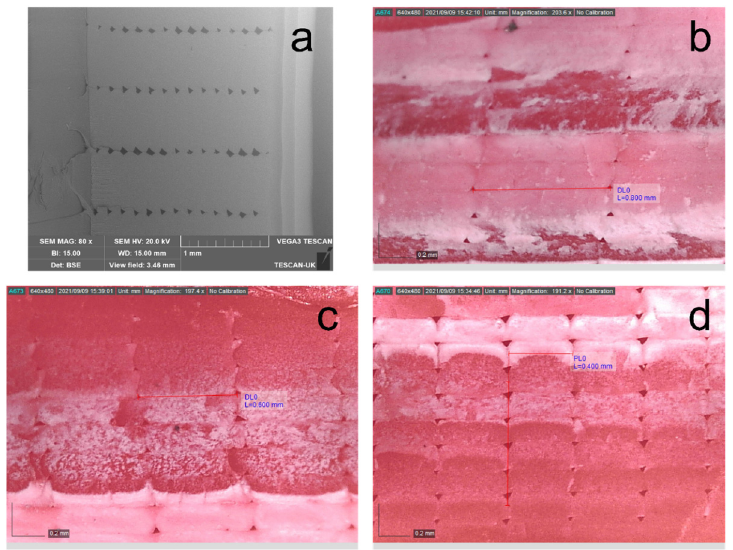
Figure 11. Cross-section of the specimen printed with 0° raster angle and 100% infill density. ( a ) Captured using SEM. ( b ) 0.8 mm nozzle size ( c ) 0.6 mm nozzle size ( d ) 0.4 mm nozzle size.